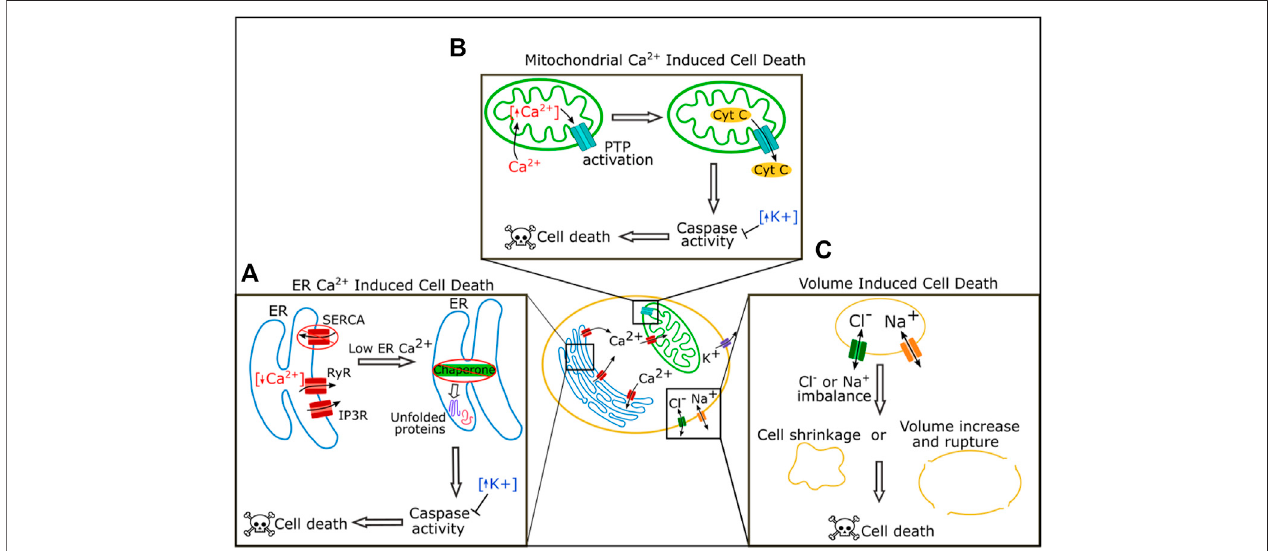
FIGURE2| Rolesofionchannelsincelldeathregulation.IntheERReductionofcalciumbyblockageofSERCAorincreasedactivityofthereceptorsRyRandIP3R canleadtolossofchaperonefunctiontriggeringtheunfoldedproteinresponsepathway,caspaseactivation,andultimatelycelldeath (A) .Inthemitochondria,increased levels of calcium lead to activation of the permeability transition pore (PTP) which can cause leakage of cytochrome C and ultimately cause cell death (B) . Chloride and sodium both regulate cell death by regulating cell volume. Extreme imbalance of chloride or sodium levels leads to cell shrinkage or volume increase and rupture, and both cause cell death (C)